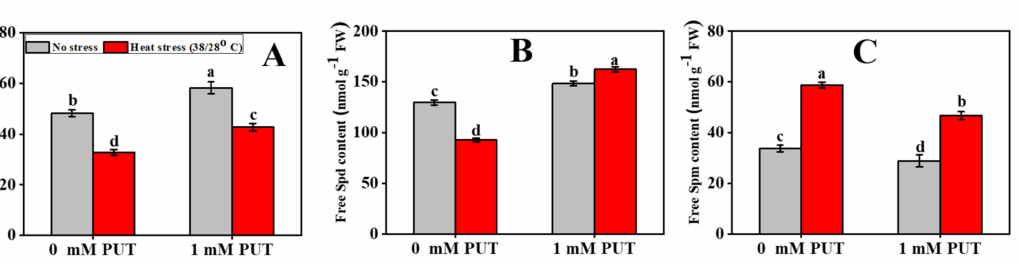
Figure 10. Interactive effects of Putrescine and high temperature on free polyamine content in tomato seedlings. ( A ) Free putrescine (Put) content, ( B ) Free spermidine (Spd) content, and ( C ) Free spermine (Spm) content. The data denote the mean value ± standard error (n = 3). Different alphabetic letters represent the significant differences among the treatments at p < 0.05, according to Tukey’s